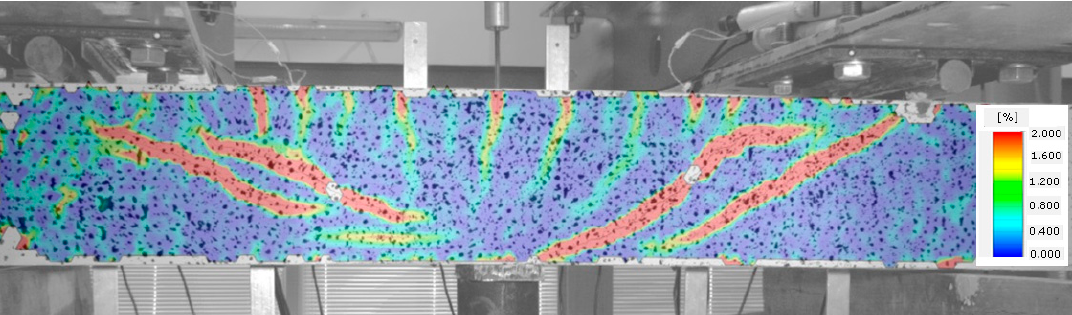
Figure 12. Stage IV of shear behavior of element—stabilization of the diagonal crack and arriving at the shear capacity.